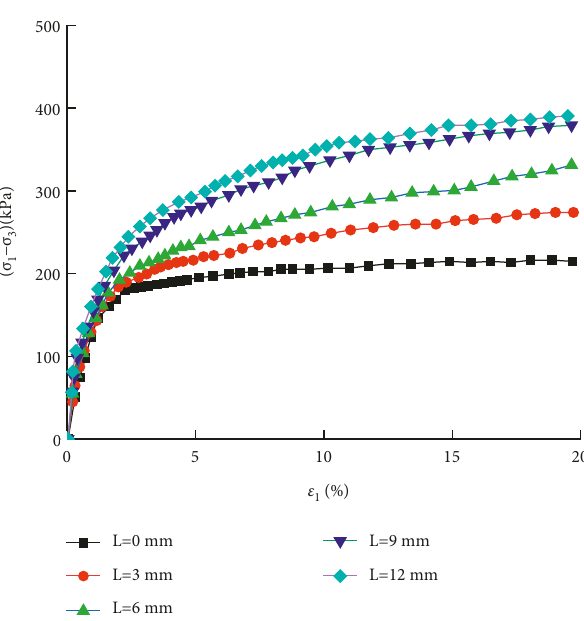
Figure 7: Relationship between stress–strain curves of different fiber lengths.